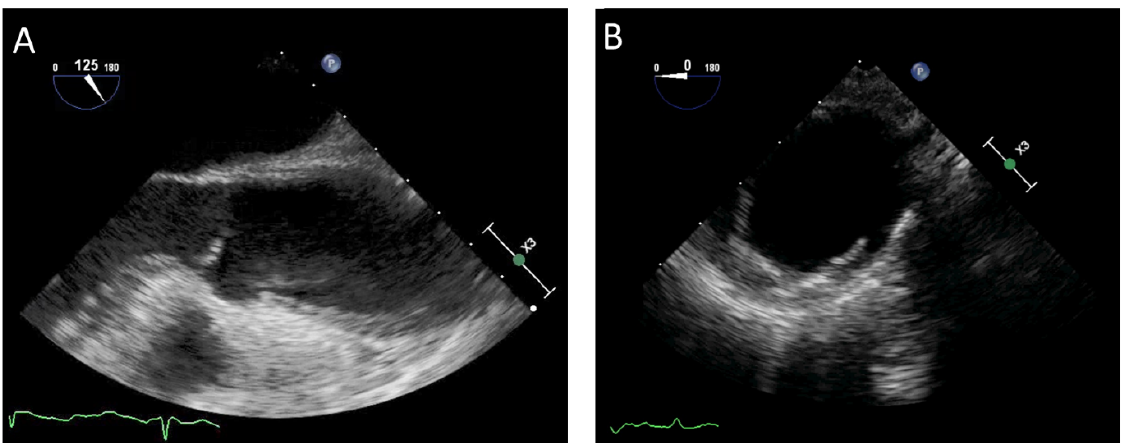
Figure 2. Transesophageal echocardiography assessment in two different patients with acute aortic syndrome: ( A ) intramural hematoma and ( B ) penetrating aortic ulcer. syndrome: ( A ) intramural hematoma and ( B ) penetrating aortic